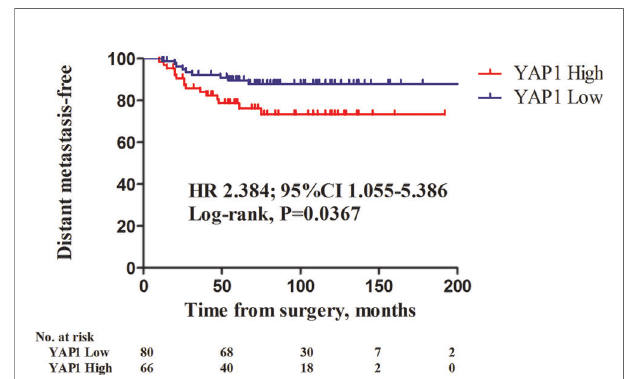
FIGURE 3 | Kaplan-Meier survival curves of distant metastasis-free survival (DMFS) in relation to nuclear YAP1 expression in triple-negative breast cancers (TNBCs). Patients with high nuclear YAP1 expression exhibited poor DMFS (HR 2.384, 95% CI 1.055 – 5.386, P = 0.0367;